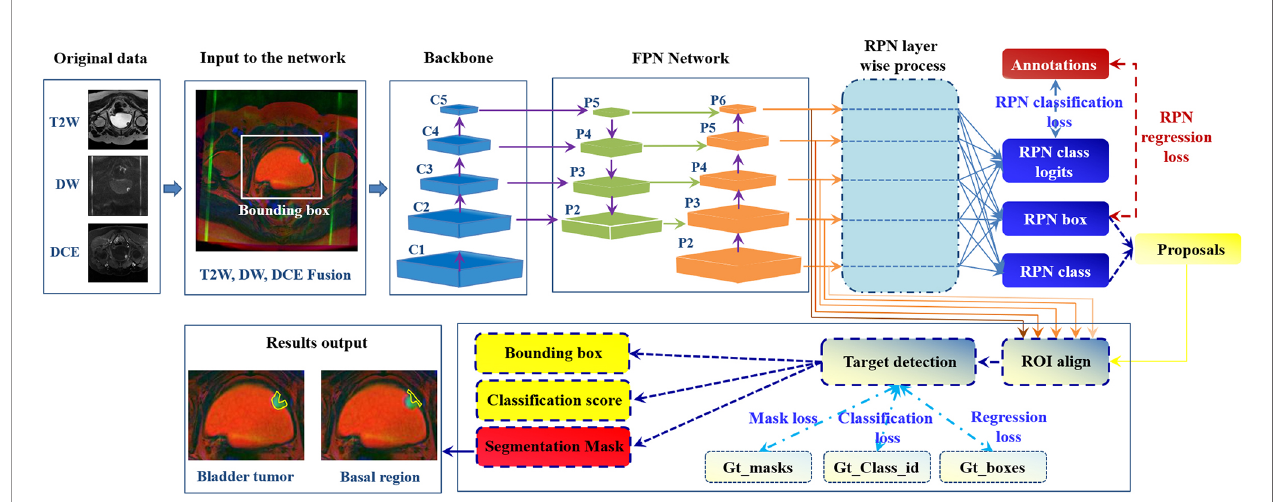
FIGURE 4 | Future framework of simultaneous segmentation of the multi-target regions from the bladder mpMRI. The Gt_class_id, Gt_boxes, and Gt_masks represent the ground truth of the multiregion anatation, position of the regions to be detected and focused, and segmentation mask